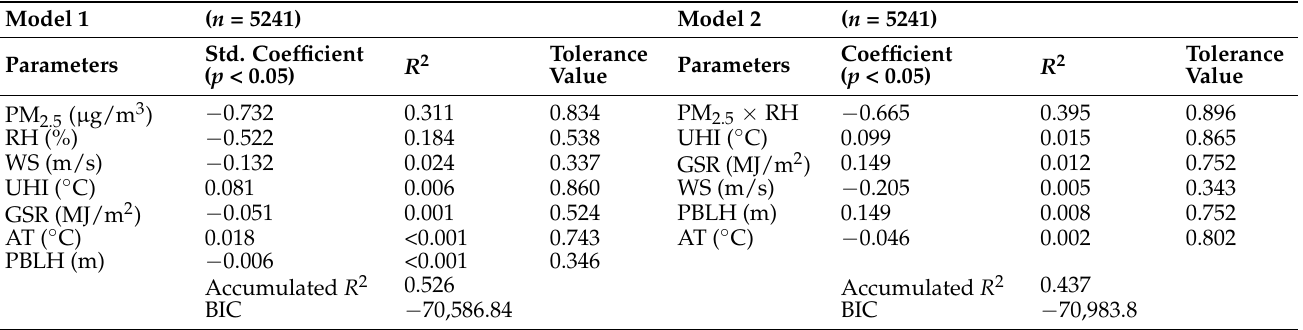
Table 8. Parameters, coefficient, R 2 , tolerance value, and Schwarz’s BIC value of the final multi- regression models (Models 1 and 2) during the winter under synoptic weather pattern type